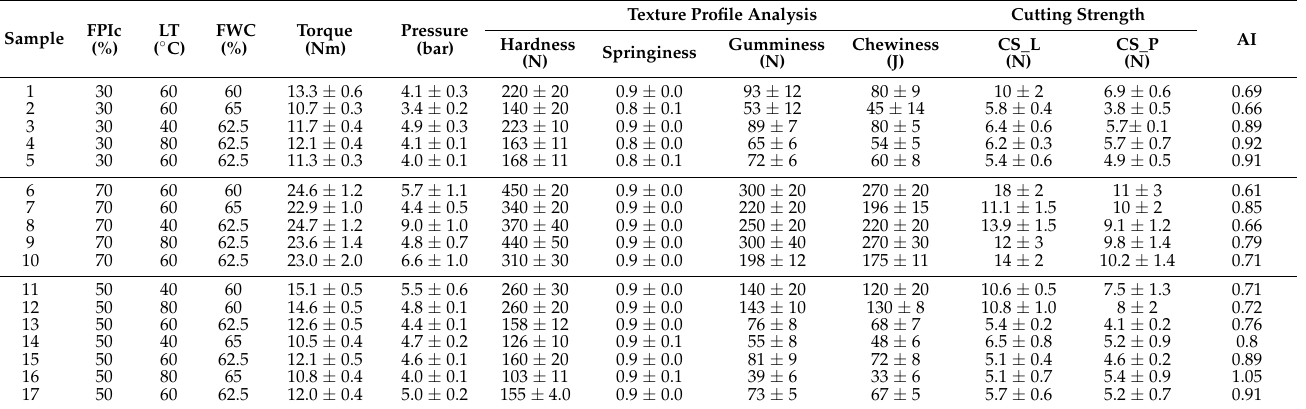
Table A2. Pressure and torque recorded during extrusion and results from the texture profile analysis; cutting strength longitudinal (CS_L), cutting strength perpendicular (CS_P), and the anisotropy index (AI) of the samples with different independent variables, including faba bean protein isolate content (FPIc), temperature of the long cooling die (LT), and feed water content (FWC).